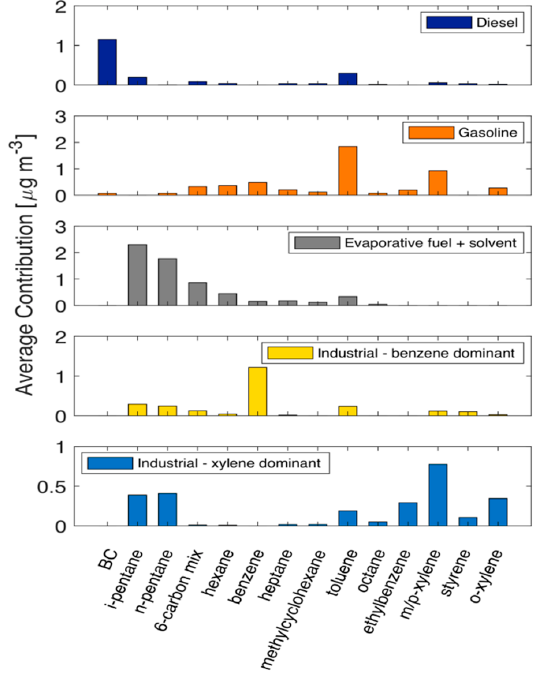
Figure 9. Factor profiles for the five-factor solution of the Positive Matrix Factorization (PMF) model based on the speciated VOC concentrations along with BC concentrations.